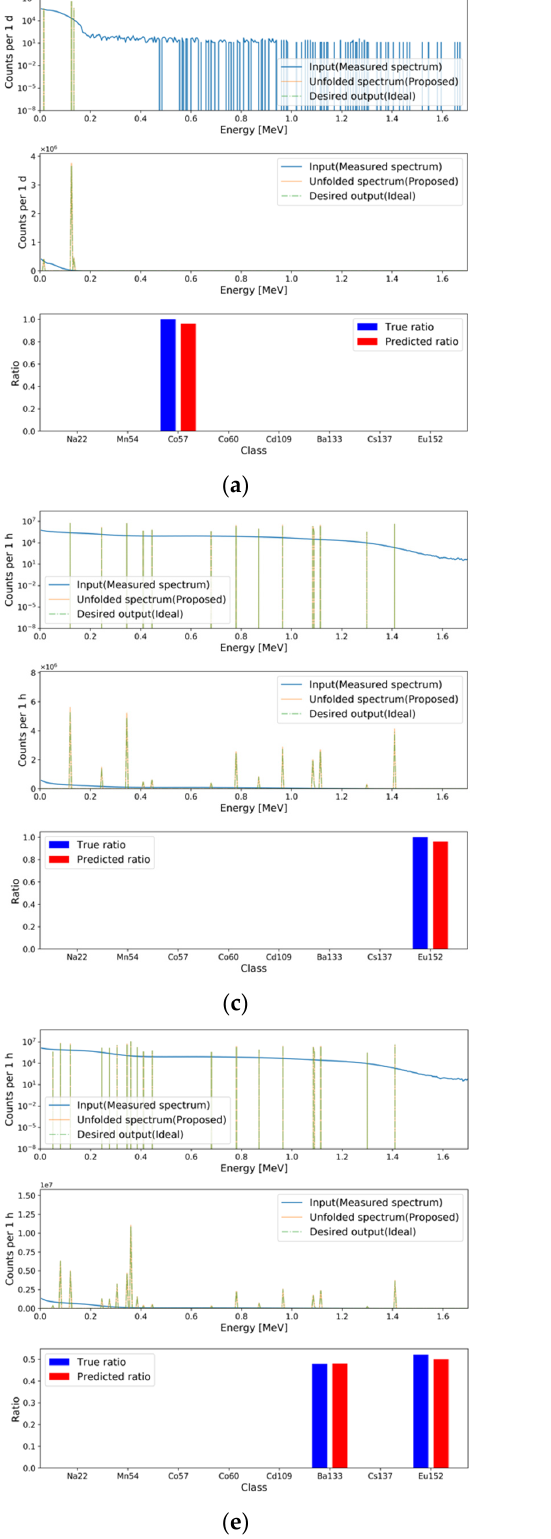
mean averaged percentage errors (MAPEs) for the generation and regression tasks, respectively, were ( a ) 9.083 × 10 − 2 and